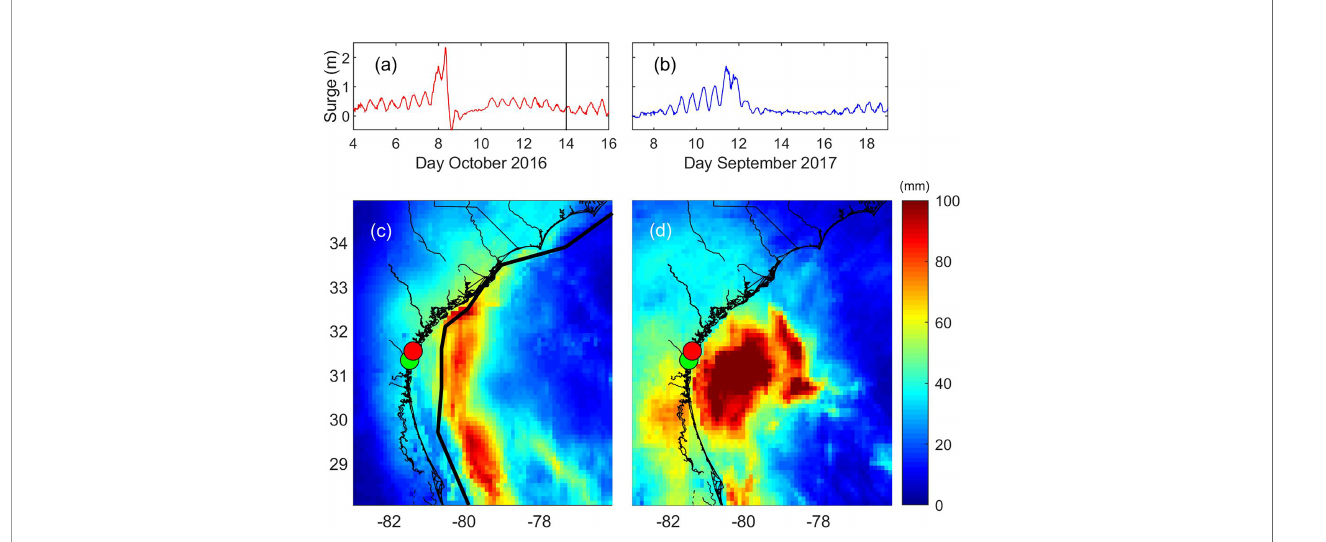
FIGURE 3 | Time series of sea level anomaly (i.e., removing predicted tides) during the passage of Hurricanes (A) Matthew and (B) Irma. Black vertical line in (A) indicates sampling period. Bottom panels show time-averaged maps of daily accumulated precipitation (mm) for (C) 6-9 October 2016 (Hurricane Matthew) and (D) 10-12 September 2017 (Hurricane Irma). Thick black contour in (C) shows Hurricane Matthew